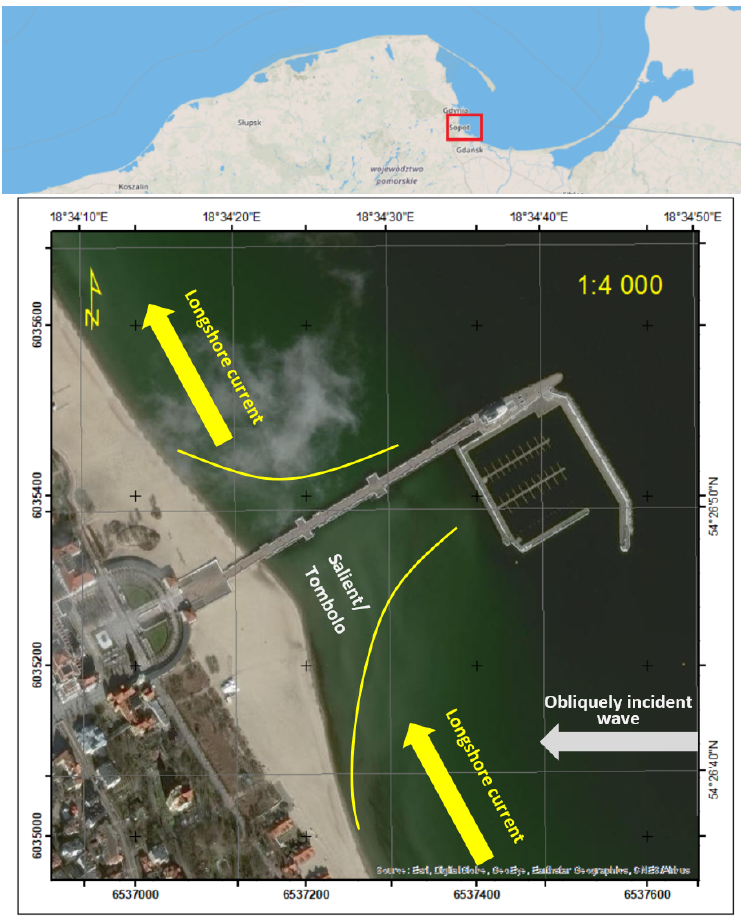
Figure 2. The nature of the phenomenon that causes the formation of the tombolo e ff ect